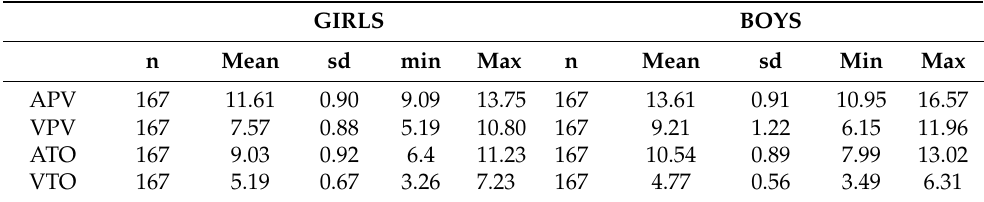
Table 1. Descriptive statistics for the parameters of the adolescent spurt in height—reference values— for girls and boys in the Brno Growth Study; units: years (for APV and ATO) and cm per year (for VPV and